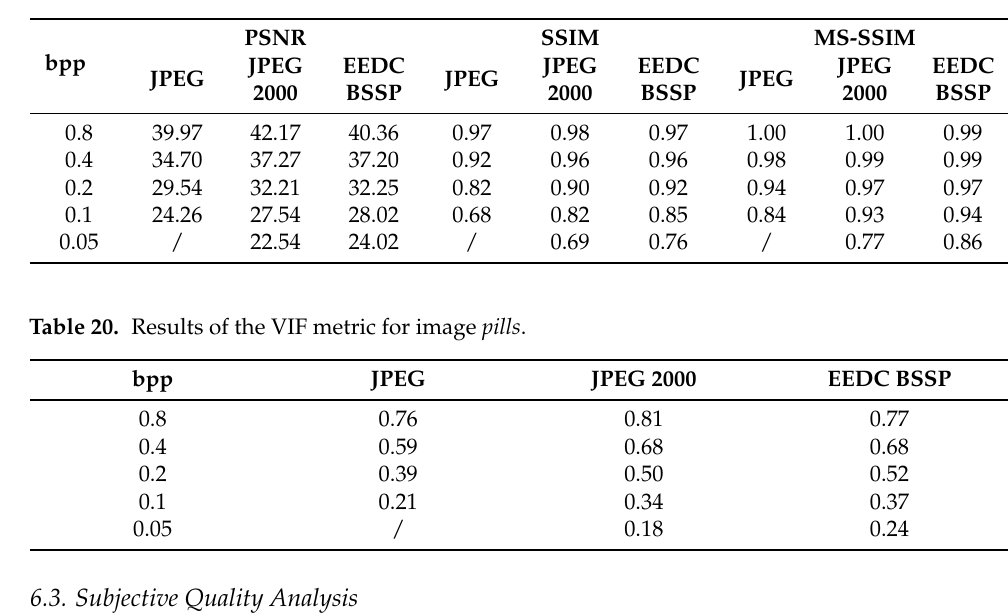
Table 19. Results of the PSNR, SSIM, and MS-SSIM metrics for image pills .